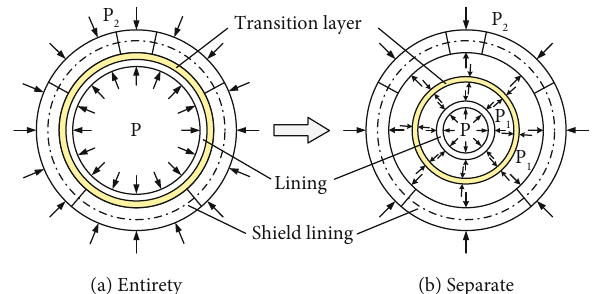
Figure 1: Mechanical analysis model of composite double-layer